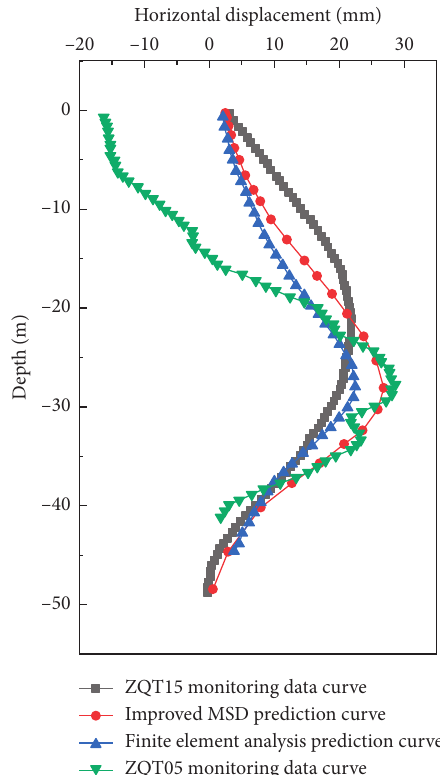
Figure 18: Comparison between the predicted value and the monitored